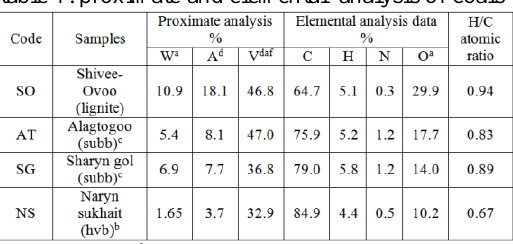
table 1. proximate and elemental analysis of coals